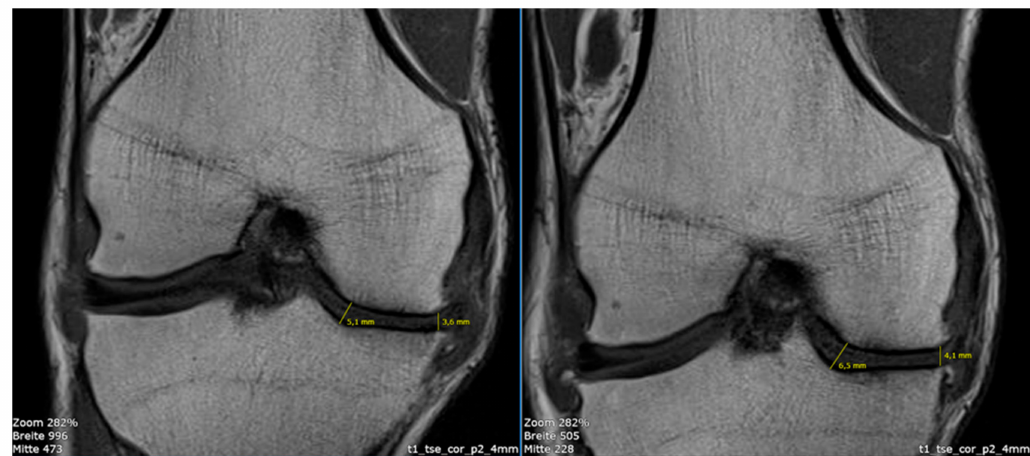
Figure 4. Magnetic resonance imaging (MRI) status of the right knee joint before treatment with the SVF and PRP ( left ), showing a joint space of 5.1 mm at the saddle point and 3.6 mm in the medial area. At 14 months after treatment with the SVF and PRP ( right ), the joint space was 6.5 mm at the saddle point and 4.1 mm in the medial area.